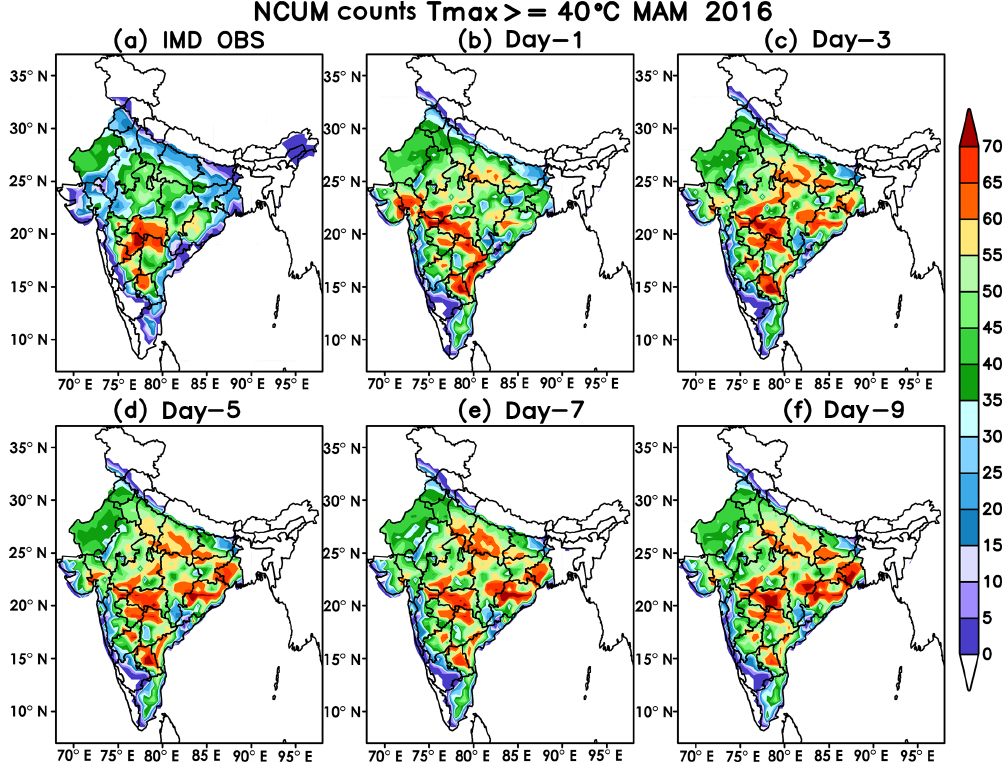
Figure 2. Spatial distribution of observed (a) and NCUM forecasts (b–f) number of days with T max ≥ 40 ◦ C during the period of March to May 2016 (NCUM stand for NCMRWF unified model; observed data from India Meteorological Department and forecast data from NCMRWF]. Regions with over 60 days of T max ≥ 40 ◦ C are indicated in orange and red. In the observations (a) this is confined to a small part over the peninsula. The NCUM forecasts (b–f) show that T max ≥ 40 ◦ C is widespread over northern and eastern parts of